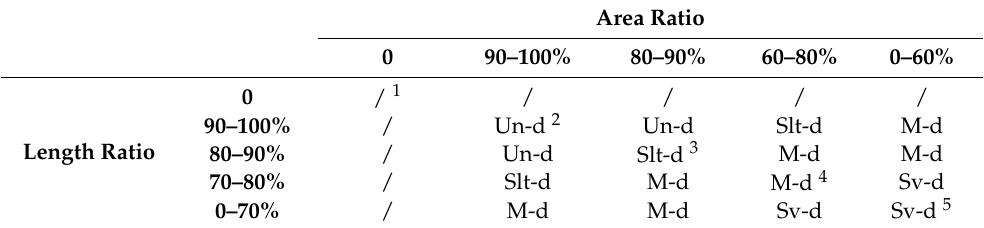
Table 1. The discriminant matrix of assessment on line-type marking